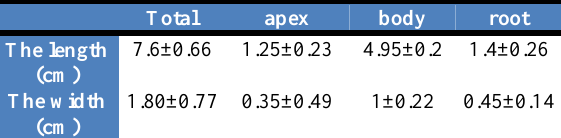
Table, 1: Dimension of the tongue of Porcupine ( Hystrix cristata ),